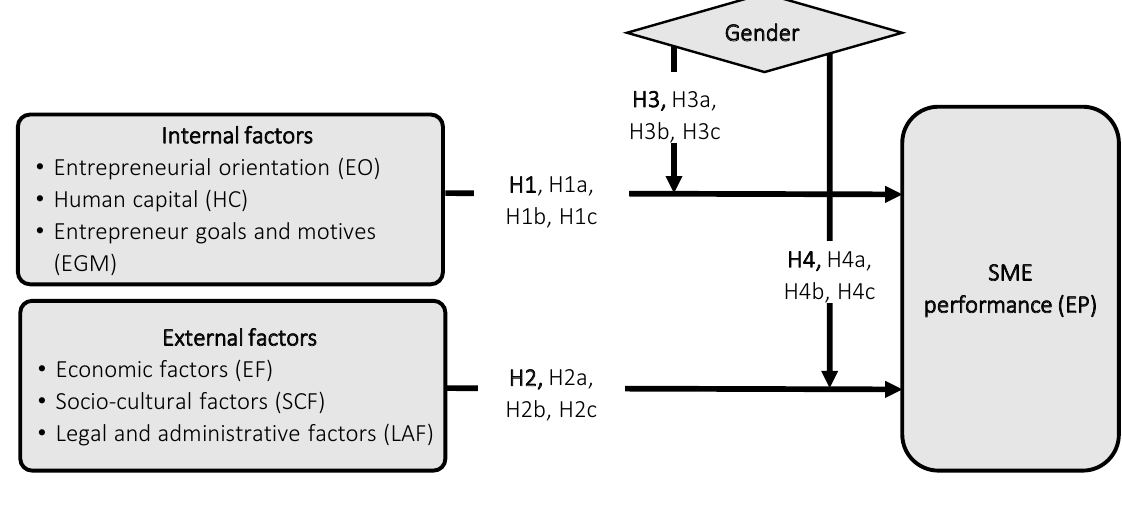
Figure 1. Conceptual model